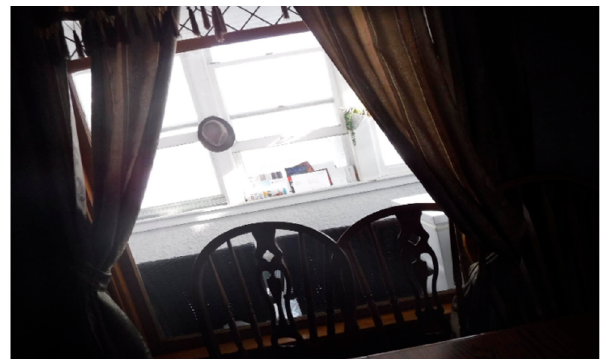
Figure 4. A photo of a window that an older adult looked through to see her loved ones when they came to visit.